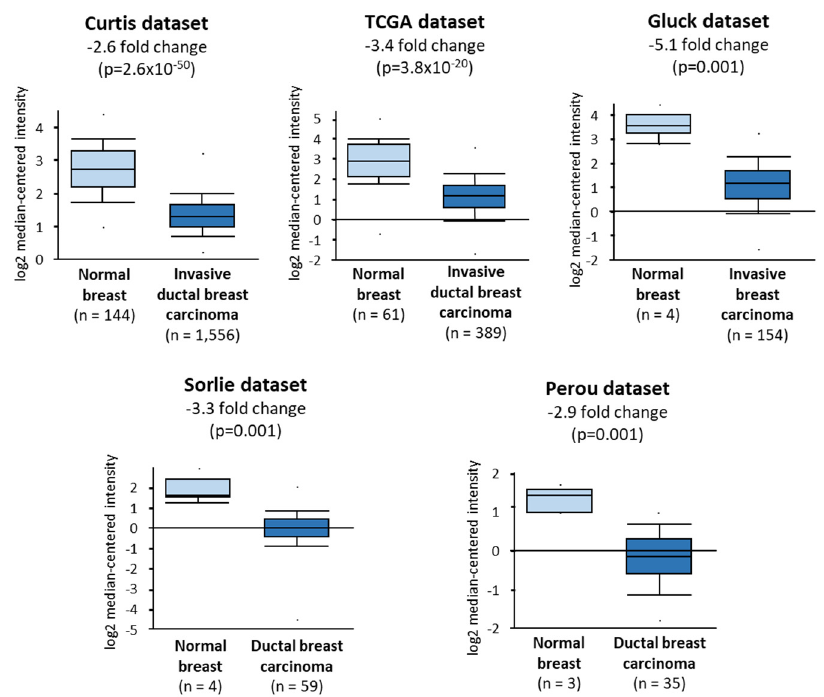
Figure 4. TIE2 expression is decreased in the primary tumor of breast cancer patients. Relative TIE2 expression was compared between the normal breast tissue and the primary tumor of BCa patients diagnosed with invasive ductal breast carcinoma [33,34], invasive breast carcinoma [35], or ductal breast carcinoma [36,37]. Relative TIE2 expressions are represented as box-plots and were compared using an unpaired Student’s t -test.